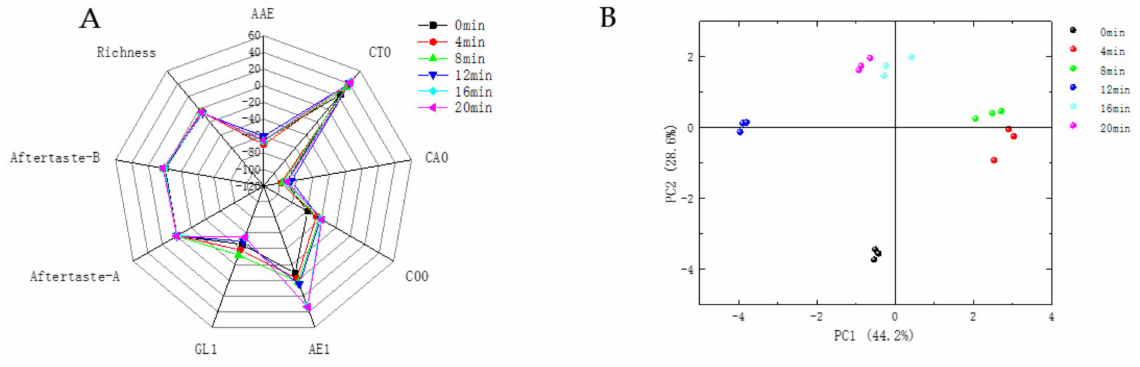
Figure 5. Radar diagram ( A ) and PCA ( B ) of defatted tiger nut flour for